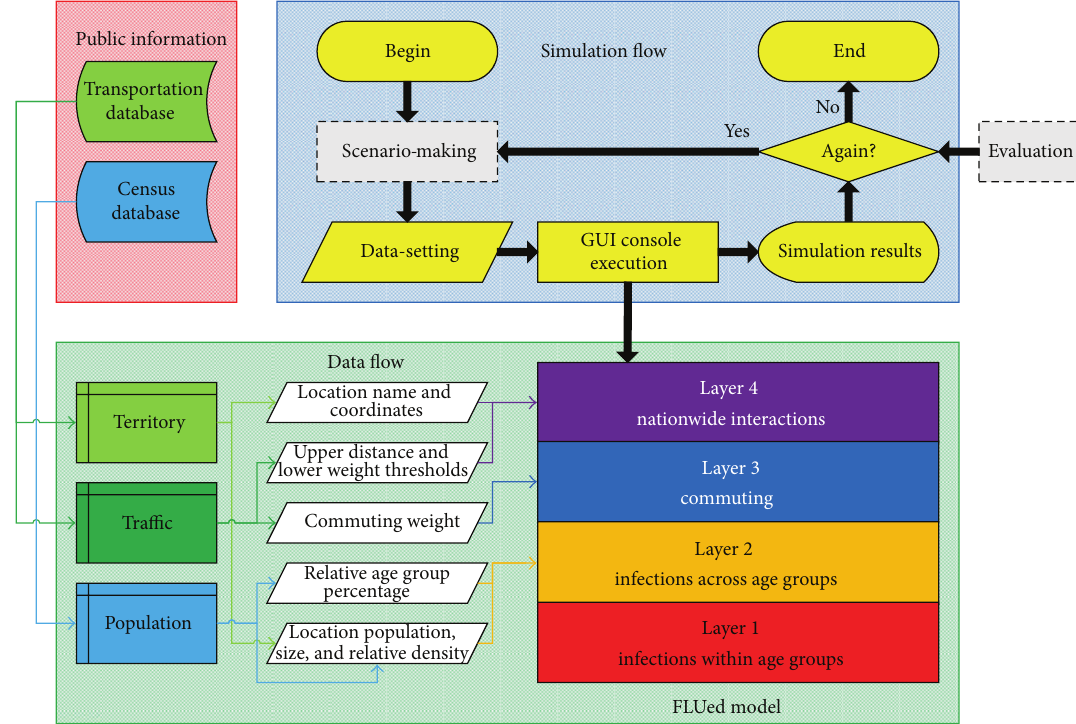
Figure 2: FLUed model implementation